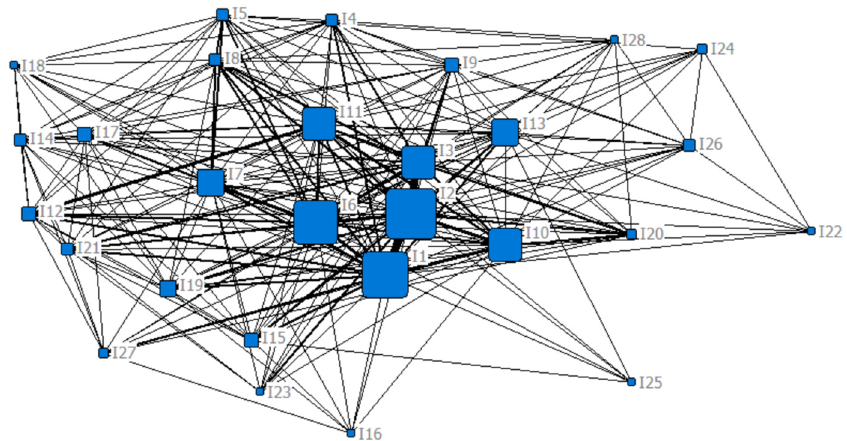
Figure 3. The social network of the influencing factors of Chinese urban community function loss under the flood disaster with the added degree centrality attribute.